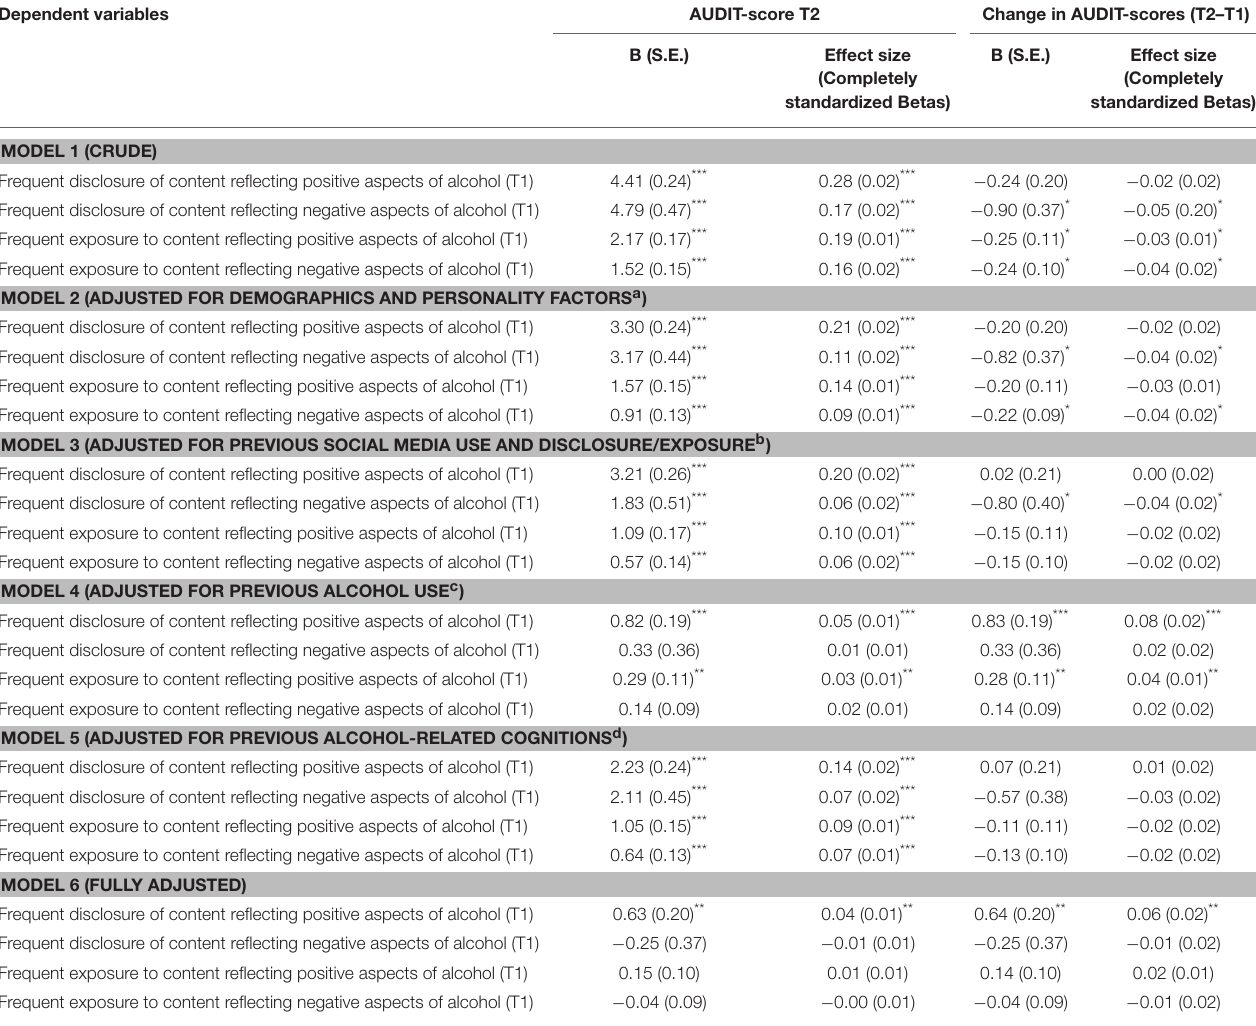
TABLE 4 | Disclosure/exposure and later alcohol use, while controlling for different covariates (n =